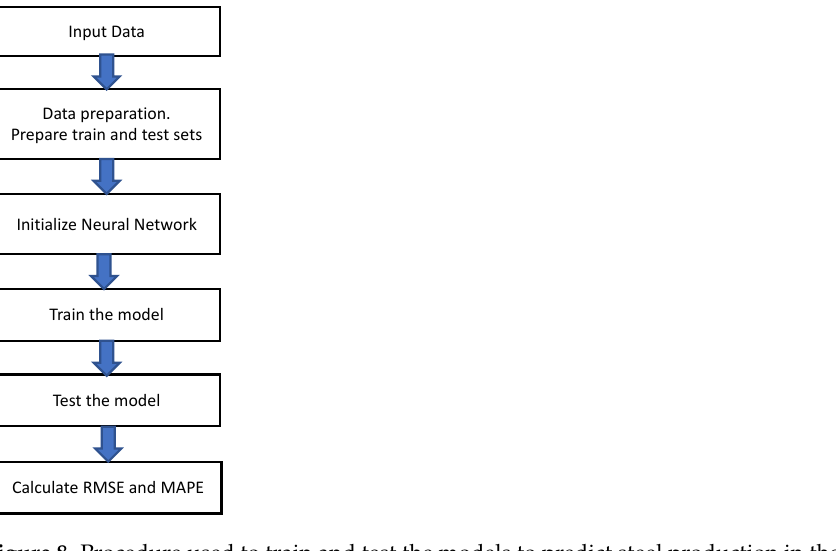
Figure 8. Procedure used to train and test the models to predict steel production in the world. Table 2. Predictive models with the best